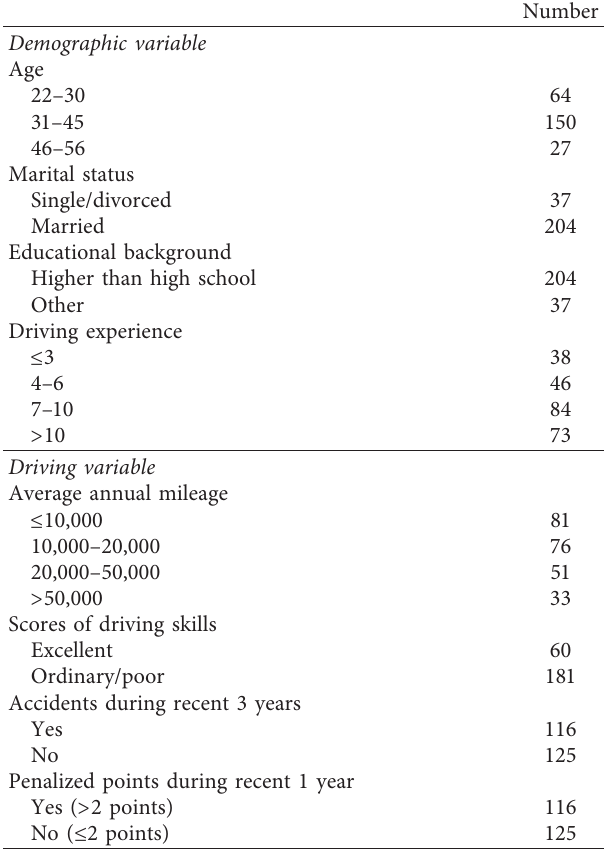
Table 1: Distribution of driver’ demographic/driving